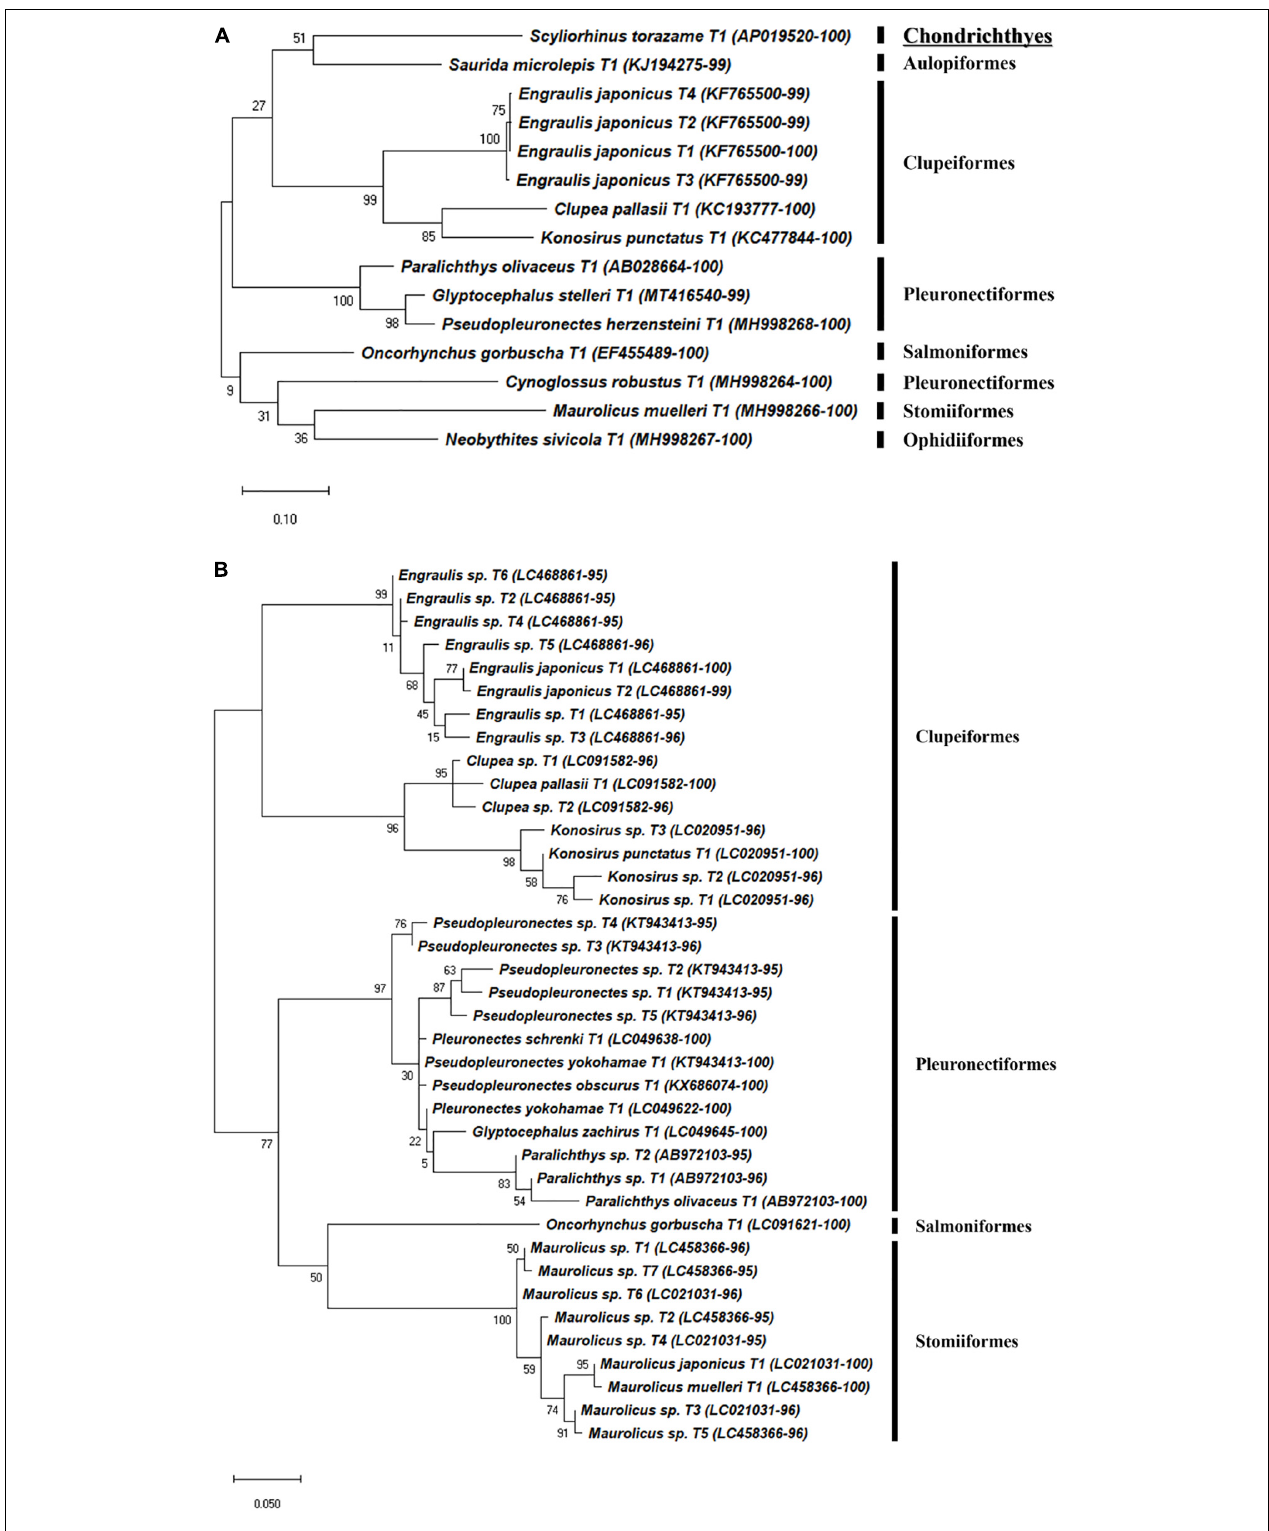
FIGURE 6 | Phylogenetic analysis of representative haplotypes belongs to eight orders generated by (A) FishU primers and (B) MiFish primers. Phylogenetic tree was constructed by maximum-likelihood algorithm (MEGA-X) under 1000 bootstrap replications.